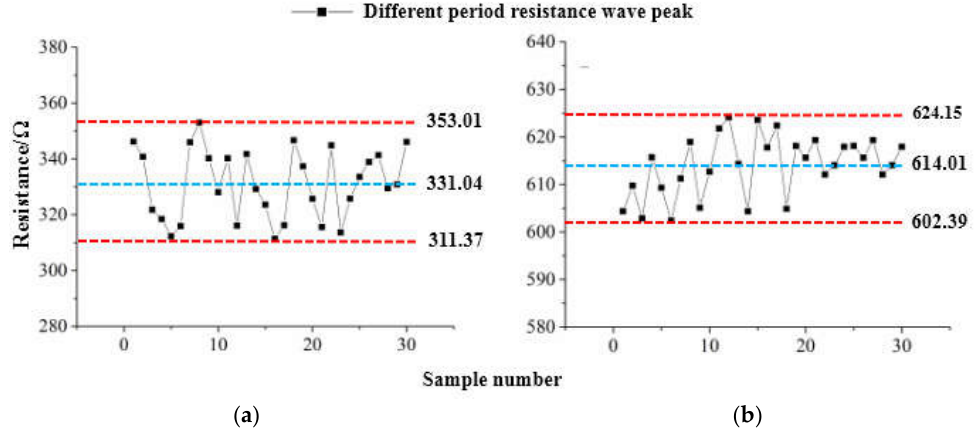
Figure 12. Schematic diagram of peak resistance in continuous cycle under dynamic load. ( a ) Resistance change diagram at 10kN. ( b ) Resistance change diagram at 60kN.